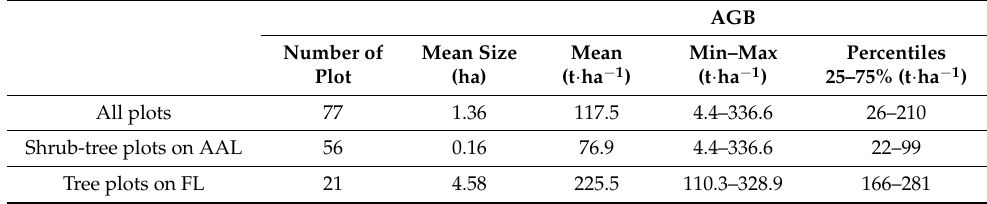
Table 1. Reference database: descriptive statistics of ground plots.